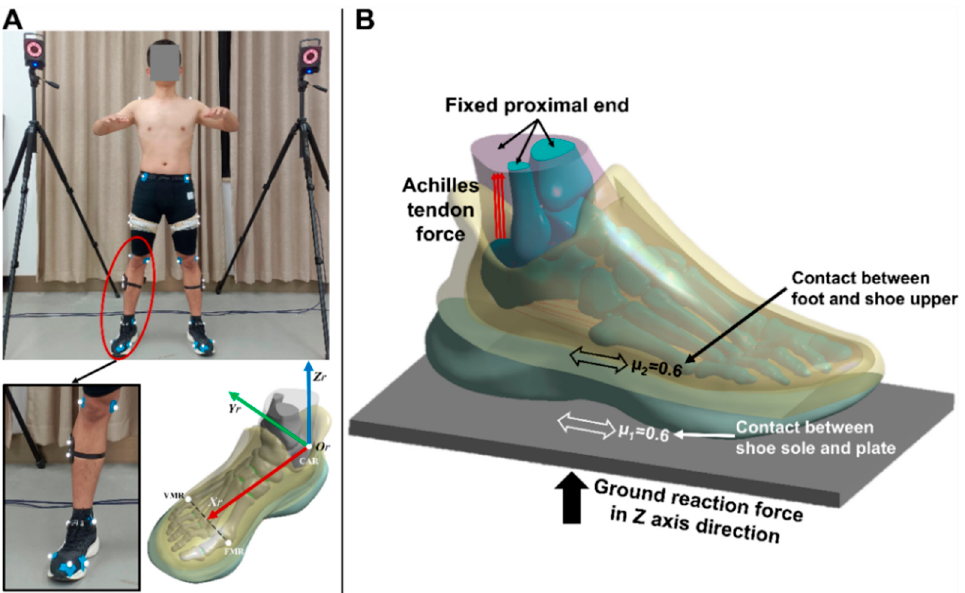
Figure 2. The application of boundary and loading conditions: ( A ) the heading angles of foot in sagittal and coronal plane were further calculated based on the Euler angles of foot rigid body coordinate system with respect to the global coordinate system; ( B ) the foot-plate system approach used to simulate the interaction between the foot, shoe, and ground, μ 1 represents the friction coefficient between the shoe sole and plate while μ 2 represents the friction coefficient between the foot and shoe upper.